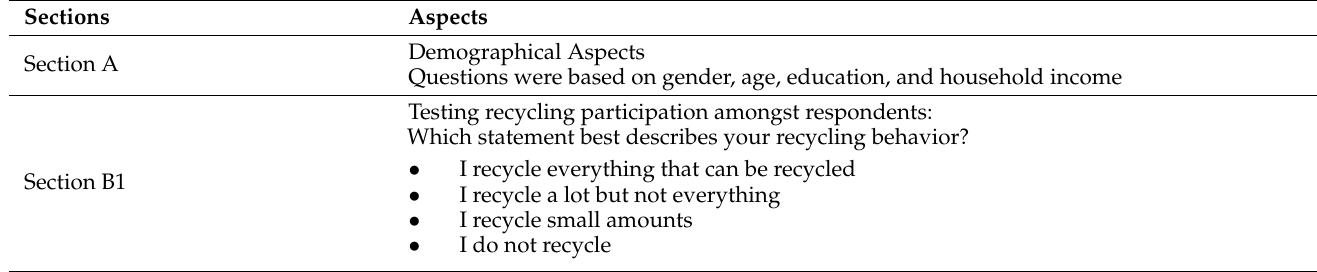
Table 1. A brief overview of the survey